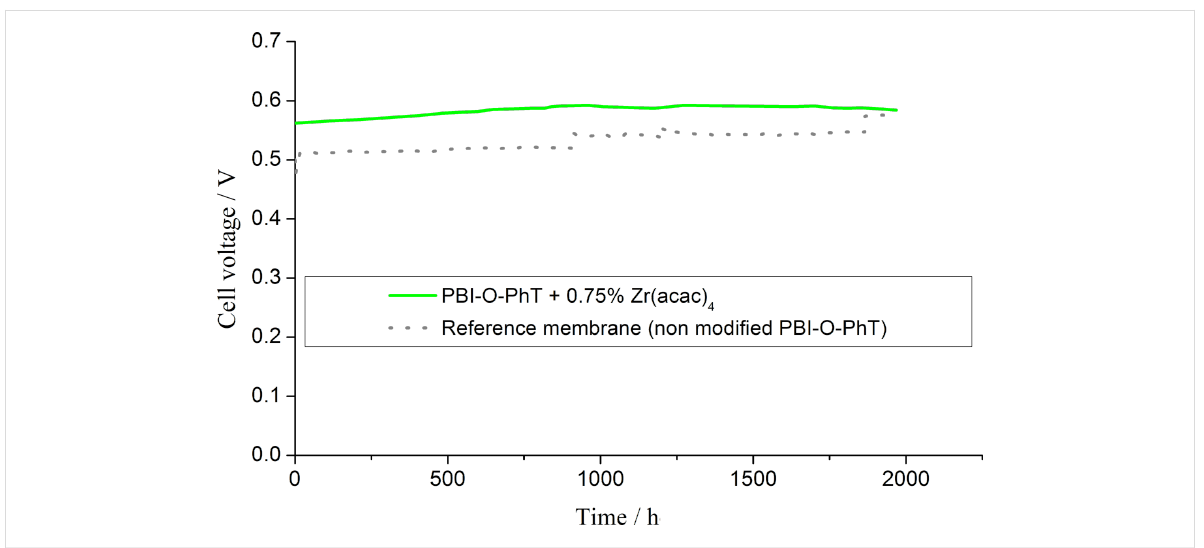
Figure 14: 2000-hour stability test of a composite PBI-O-PhT + 0.75 wt % Zr(acac) 4 membrane and the reference membrane in an operating fuel cell. H 2 /air, T = 160 °C, current density 0.4 A·cm − 2